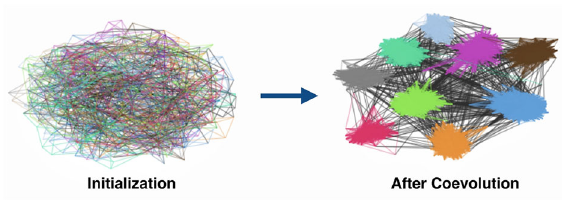
Fig.4 The coevolved society after 450 time steps. The nodes and edges within a community are set with the same color. The color of external edges connecting two communities is set to black